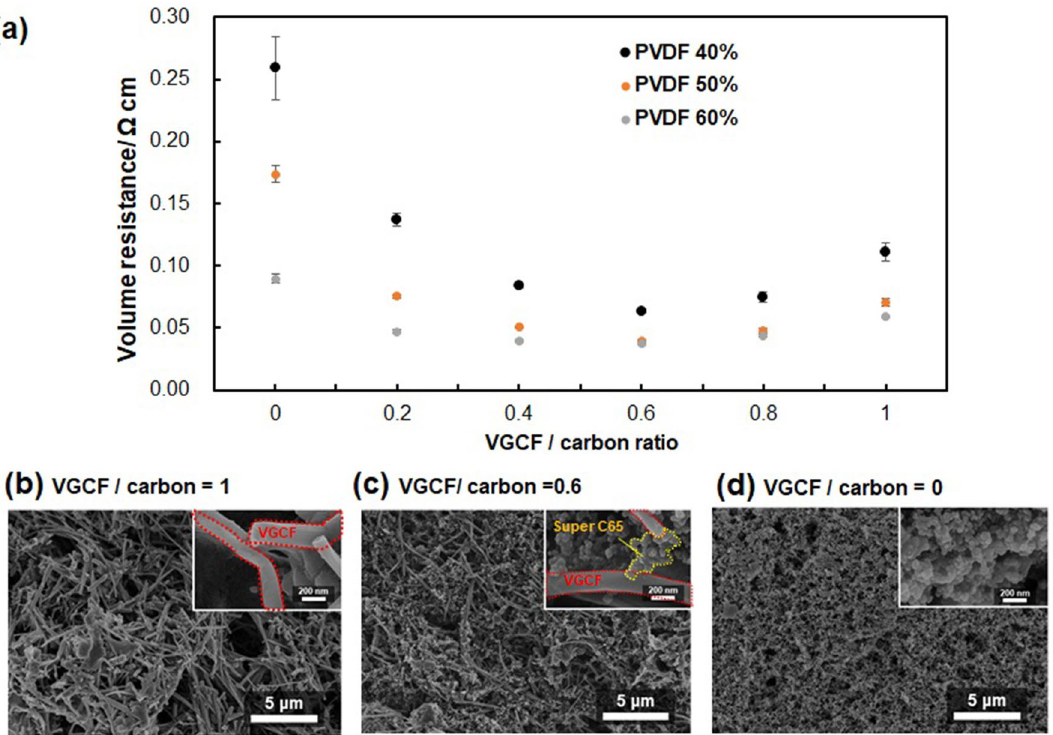
Figure 2. Optimization of the carbon collector composite slurry. ( a ) The carbon collector’s volume resistance against VGCF/carbon ratio when PVDF binder was blended 40, 50, and 60% against the slurry’s total weight. SEM images of the composites with VGCF/carbon ratio were ( b ) 1, ( c ) 0.6, and ( d ) 0 in the case of the PVDF ratio was 50%. The insets are high-magnification SEM images corresponding to each carbon water droplet’s contact angle on the paper for the oxygen plasma irradiation time. The contact angle decreased in a time-dependent manner within 5 s of irradiation and approached a constant value at more than 5 s. Then, adhesion of the first layers (carbon collector, cathode, and anode composites) to the oxygen plasma- treated silicone-based supporting papers was evaluated. Each electrode composite was prepared on the oxygen plasma-treated paper by blade coating with 125 µm thick stencils and then drying (Fig. 3c). Then, adhesive Kap- ton tape was attached to the electrode composite, followed by peeling the supporting paper’s tape. Figure 3d–f show the peeled Kapton tape (orange-color tape pointed by the red arrow) with the electrode composite from the supporting paper (white-color paper pointed by the blue arrow). All the electrode composites were success- fully peeled from the oxygen plasma-treated supporting paper. Supplementary Figure S1 shows photographs of the peeled Kapton tape from the supporting paper treated for different oxygen plasma irradiation time (1, 3, and 5 s). The collector electrode and cathode composites were spontaneously detached from the paper treated for less than threshold irradiation time (3 s for the collector electrode, 1 s for the cathode, respectively) without Kapton tape due to its weak adhesion to the paper (Supplementary Figure S2). Optimal adhesion of the carbon collector composite was achieved by treating the paper for 5 s, and it was successfully transferred onto Kapton tape. The relatively brittle manganese dioxide layer was partially destroyed during transferring. The weight of the transferred manganese dioxide composite and the remaining composite on the silicone sheet were measured and the residual ratio was calculated to be 5% for 3 s-treated paper. As the irradiation time increased to 5 s, the residual ratio increased to 8%, so that the optimal irradiation time was determined to be 3 s. On the other hand, anode composite showed good adhesion even on the 1 s-treated paper, while its adhe- sion against 5 s-treated paper was too strong to be peeled from the paper. Based on these results, the optimum oxygen plasma irradiation time against the silicone-based papers for the carbon collector, cathode, and anode composites was determined to be 5, 3, and 1 s, respectively. Next, the second adhesive/conductive layer was formed on the first layer-prepared supporting paper. The slurry consisting of graphite and PEAA was prepared into α-terpineol solvent, followed by blade-coating on the first layer. Finally, α-terpineol was removed by vacuum drying at 5 °C to prevent the solvent from soaking into the first layer. Supplementary Figure S3 shows the PEAA-graphite layers’ cross-sectional profiles and SEM images on the manganese dioxide cathode (a,c) and zinc anode layers (b,d). The cathode and anode composites’ thicknesses before and after the second layer coating were 81 to 89 µm and 49 to 57 µm, respectively, suggesting that the second layer’s thickness was about 8 µm. The SEM image of the PEAA-graphite layer on first layer (man- ganese dioxide and zinc layer) showed a clear interface between the two layers. The blend of the two layers was prevented. Figure 4a shows the demonstration of the transfer of the battery components onto a curved surface. Two carbon collectors were adhered in parallel onto the curved sidewall of a glass bottle and then heated using